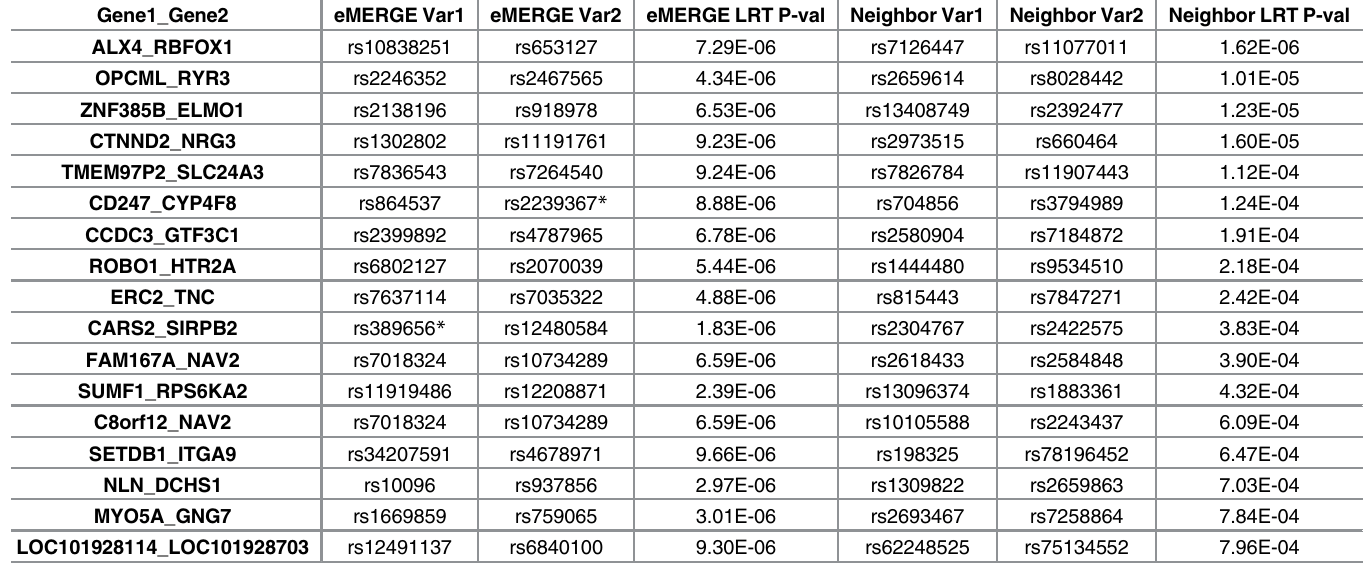
Table 2. All replicating gene-gene interactions at LRT p-value < 1e-04 for replication dataset.